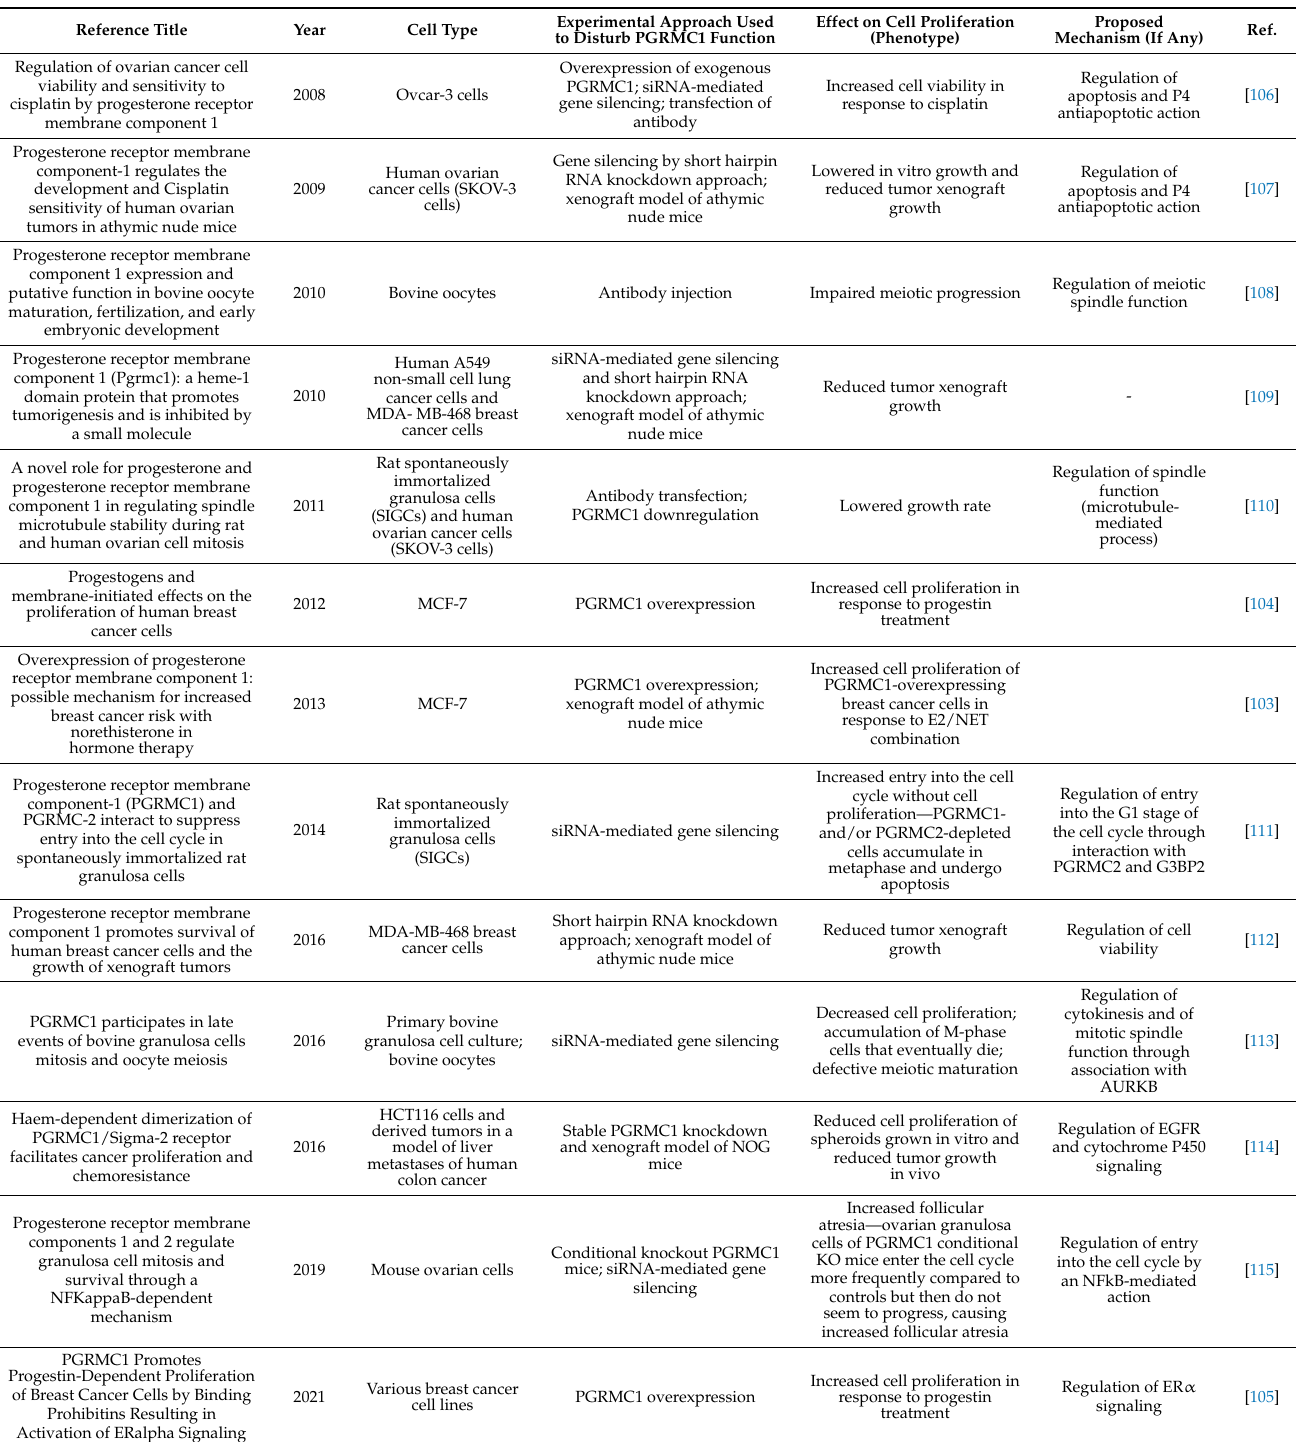
Table 1. Experimental evidence supporting a role for PGRMC1 in cell proliferation and cell